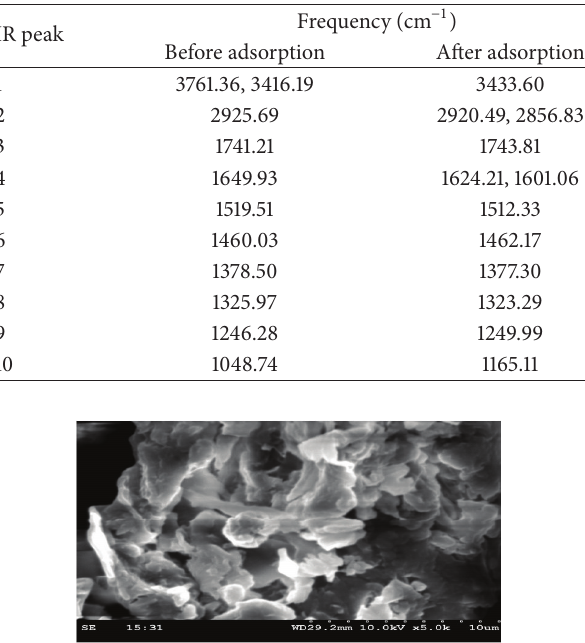
Table 1: FTIR of IJSP adsorbent alone and AB25 loaded IJSP.